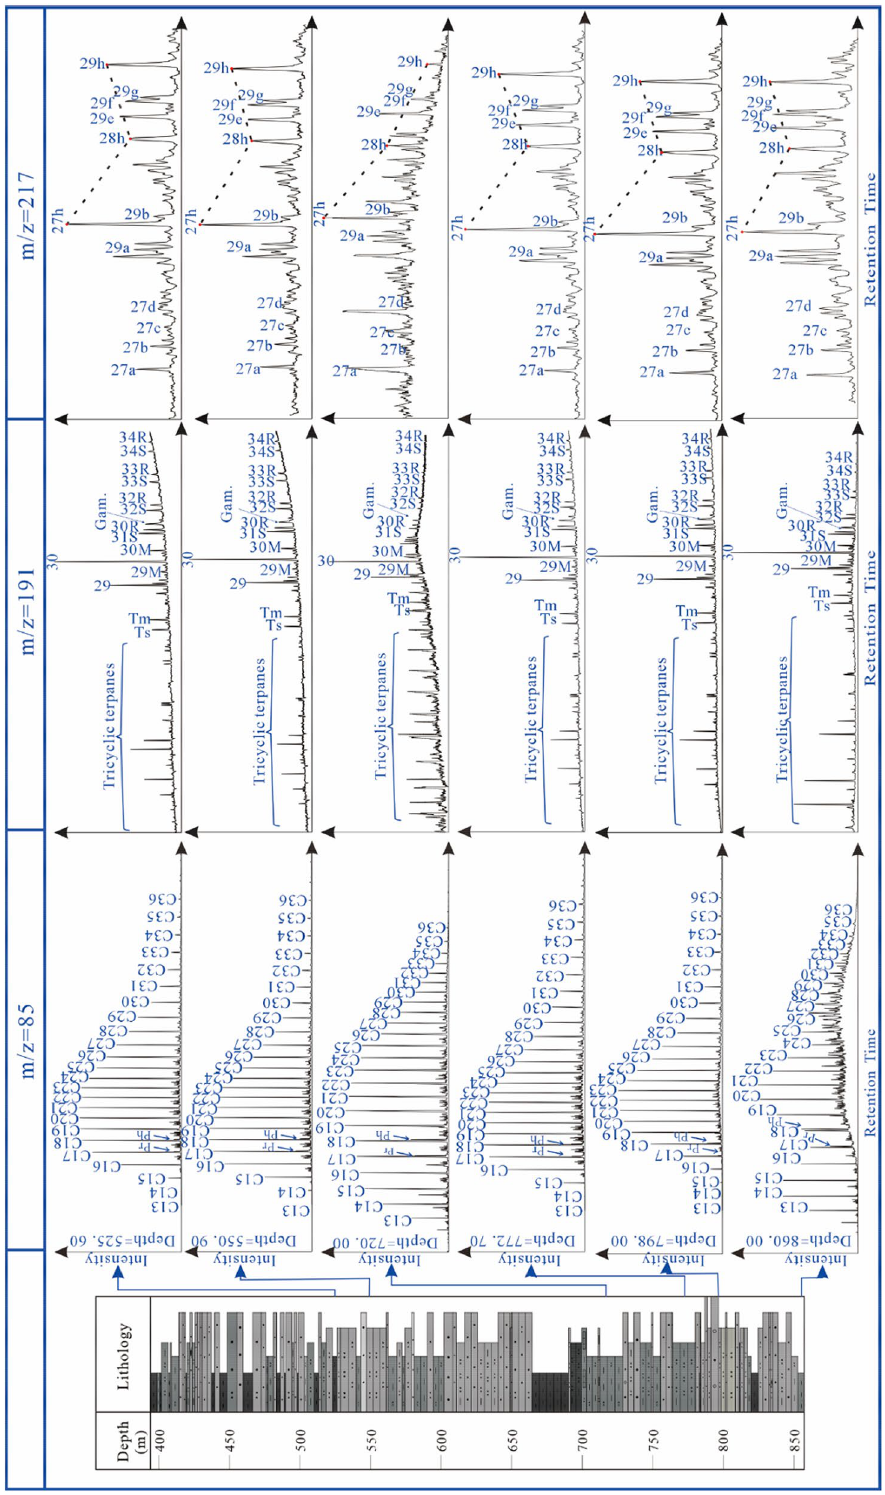
Figure 5. m/z = 85, m/z = 191, and m/z = 217 mass fragmentograms of the saturated hydrocarbon fractions of six representative Xiahuapidianzi Formation mudstone